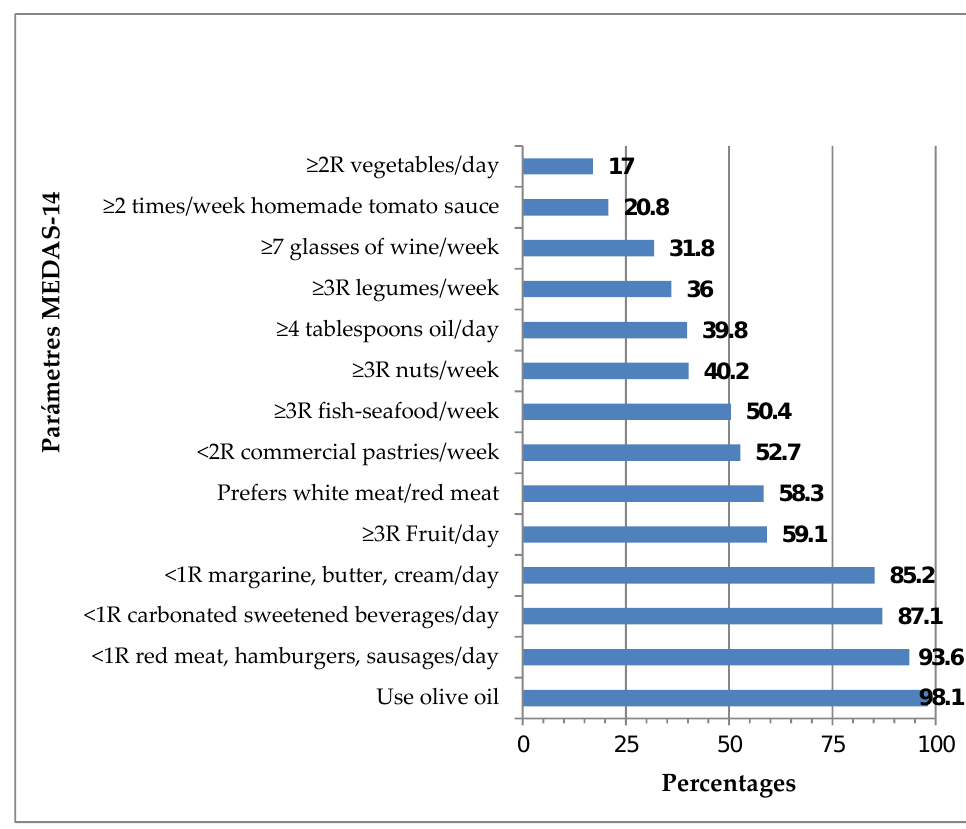
Figure 2. Adherence rates for the MEDAS-14 components.